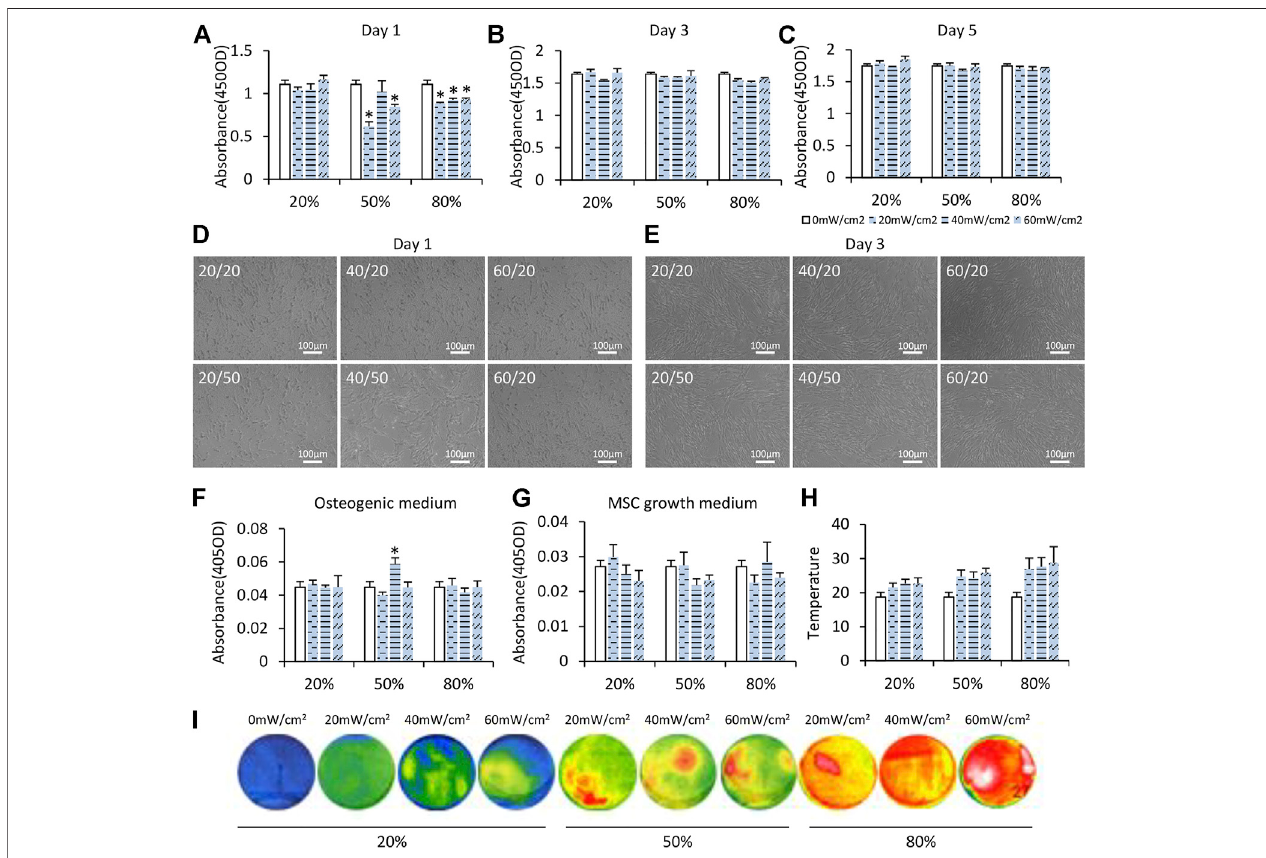
FIGURE1| PreliminaryselectionoftheoptimalLIPUSparameter foriMSCdifferentiation. (A – C) CCK-8assayofiMSCs underdailyLIPUSstimulation ondays1,3, and 5. Different output intensities and duty cycles were tested. (D,E) IMSCs under LIPUS stimulation on days 1 and 3. (F,G) ALP activity was evaluated on day 5. Cells were cultured in the osteogenic medium or MSC growth medium. (H,I) Temperature of the LIPUS device increased with DC determined by an infrared thermometer.